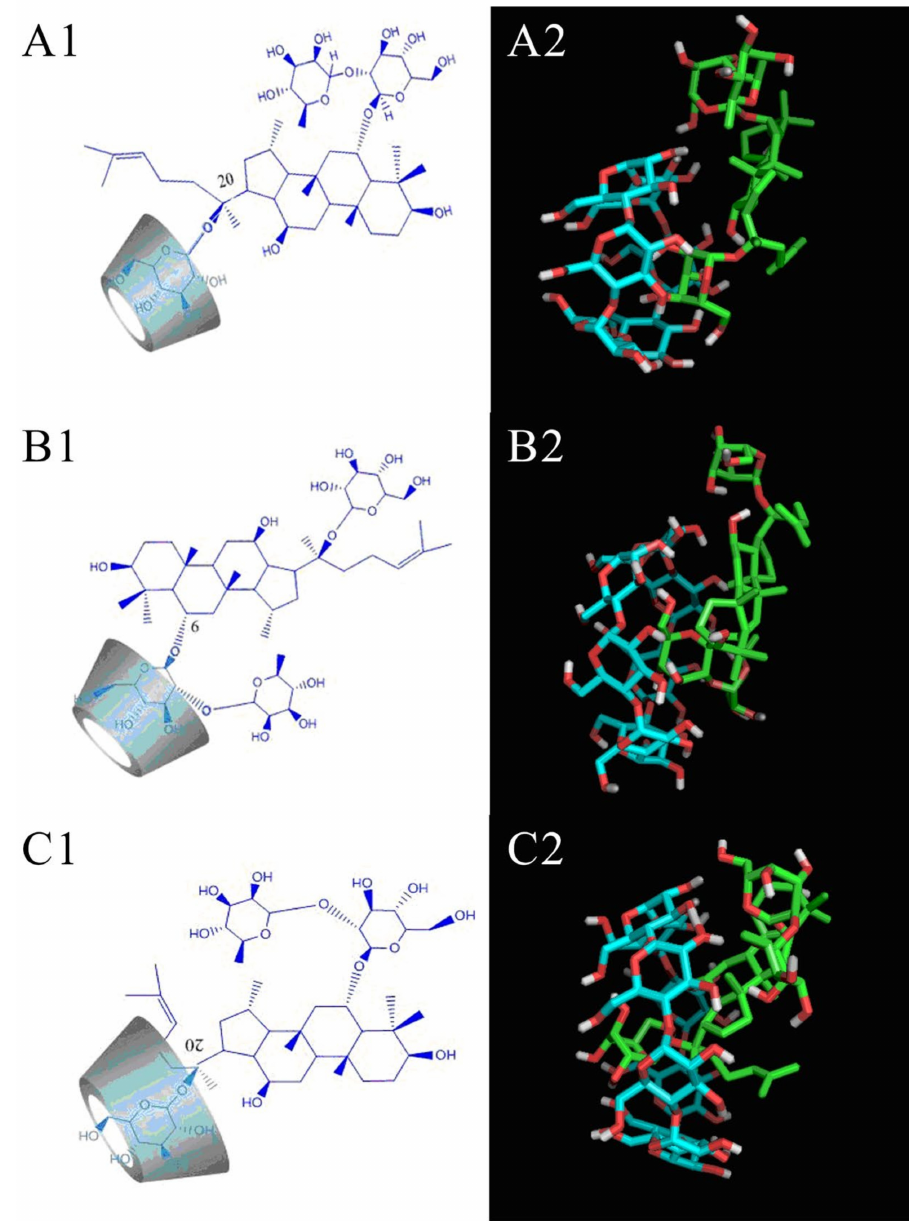
Figure 3. Molecular docking conformation diagrams of G-Re with CDs: ( A : IC of G-Re- α -CD; B : IC of G-Re- β -CD; C : IC of G-Re- γ -CD). 1: Schematic diagram of the structure of the inclusion position; 2: images of the inclusion complex from Pymol software (Pymol TM ,1.7.X). The blue sticks represented the host molecule (CDs), the green sticks represented the guest molecule (G-Re), the red part represented the oxygen atoms, and the white part represented the hydrogen